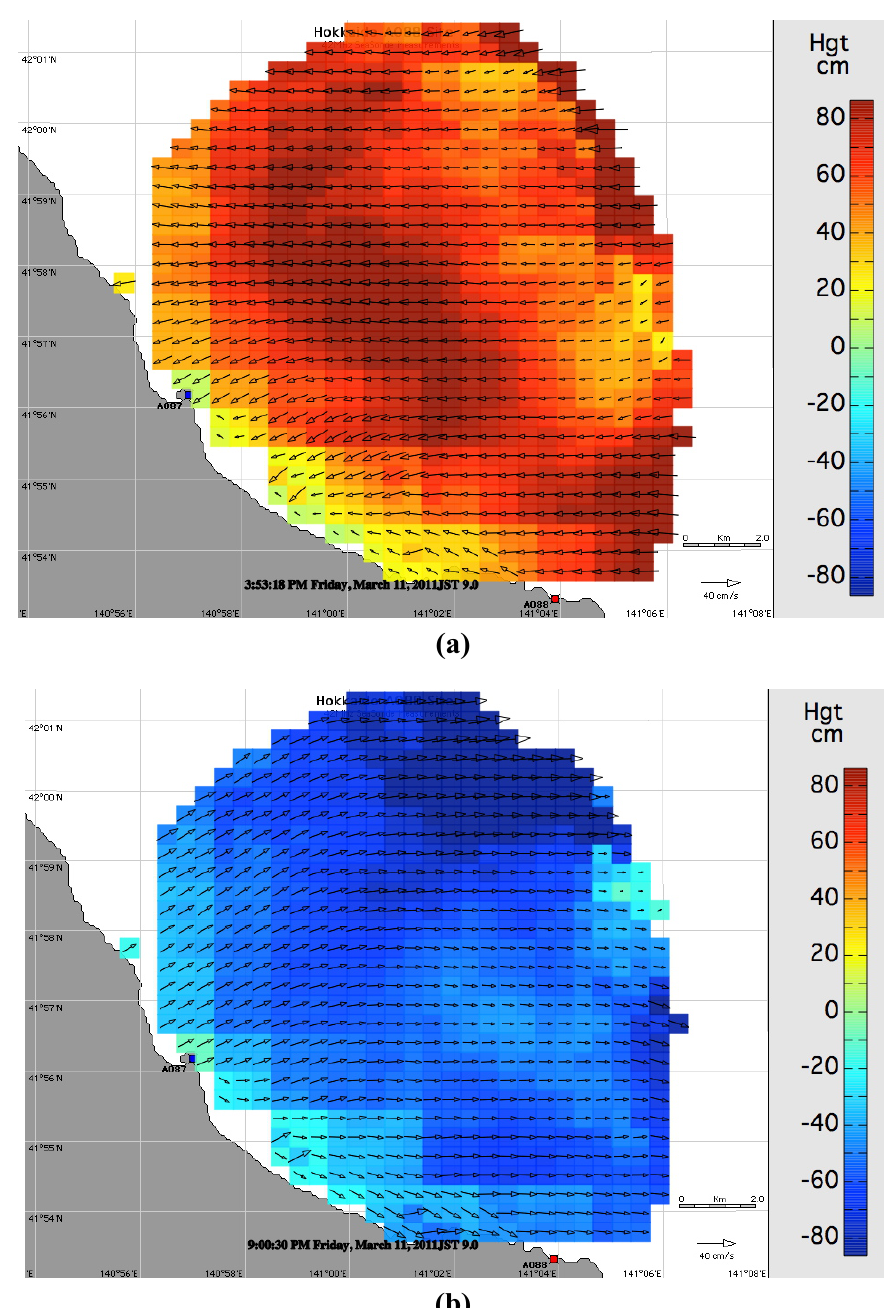
Figure 2. The tsunami height superimposed on the total current velocity field measured by radars at Usujiri (blue dot) and Kinaoshi (red dot): (a) 11 March 2011, 15:53 JST; (b) 11 March 2011, 21:00